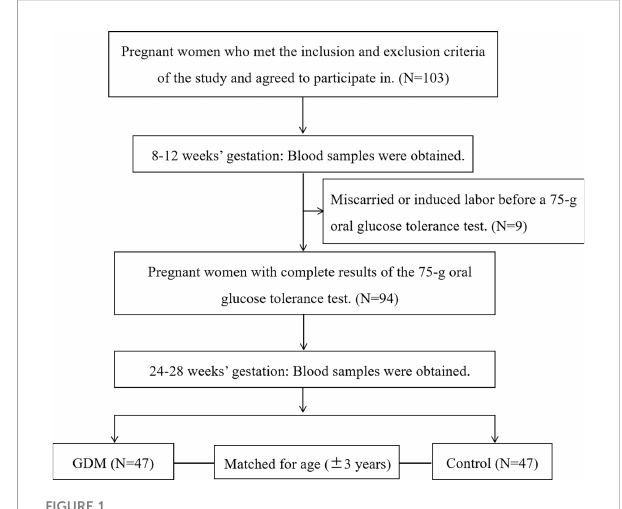
FIGURE 1 Flowchart of the included participants in this